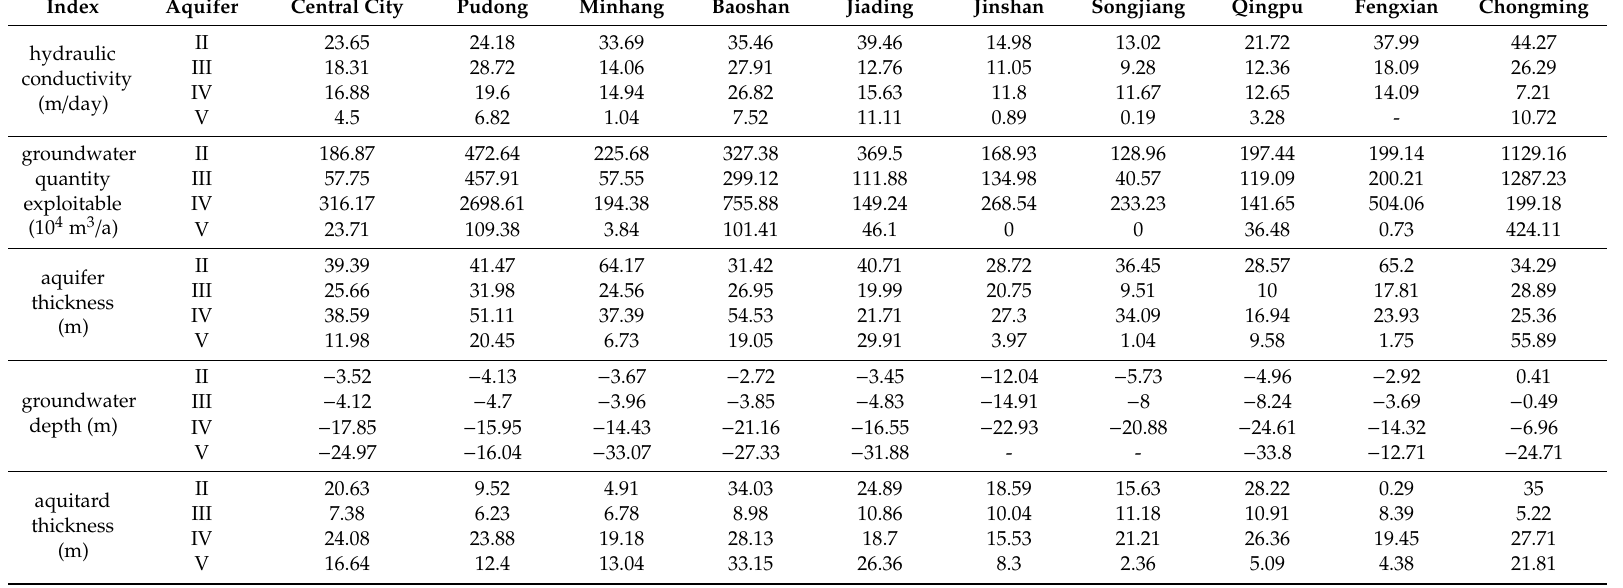
Table 4. The hydrogeological / seepage parameter values of each aquifer in